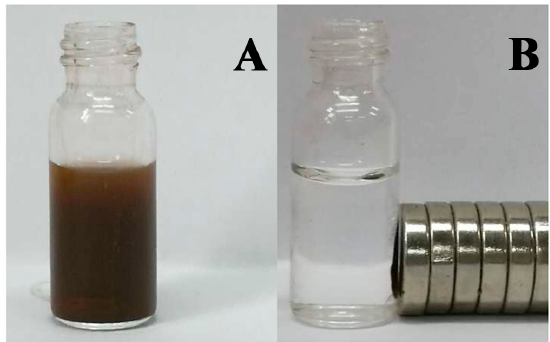
Figure 2. Schematic of the simple magnetic separation of surfactant-activated magnetic RML CLEAs: ( A ) immobilized lipase dispersed in reaction mixture; ( B ) immobilized lipase collected by an external magnet.